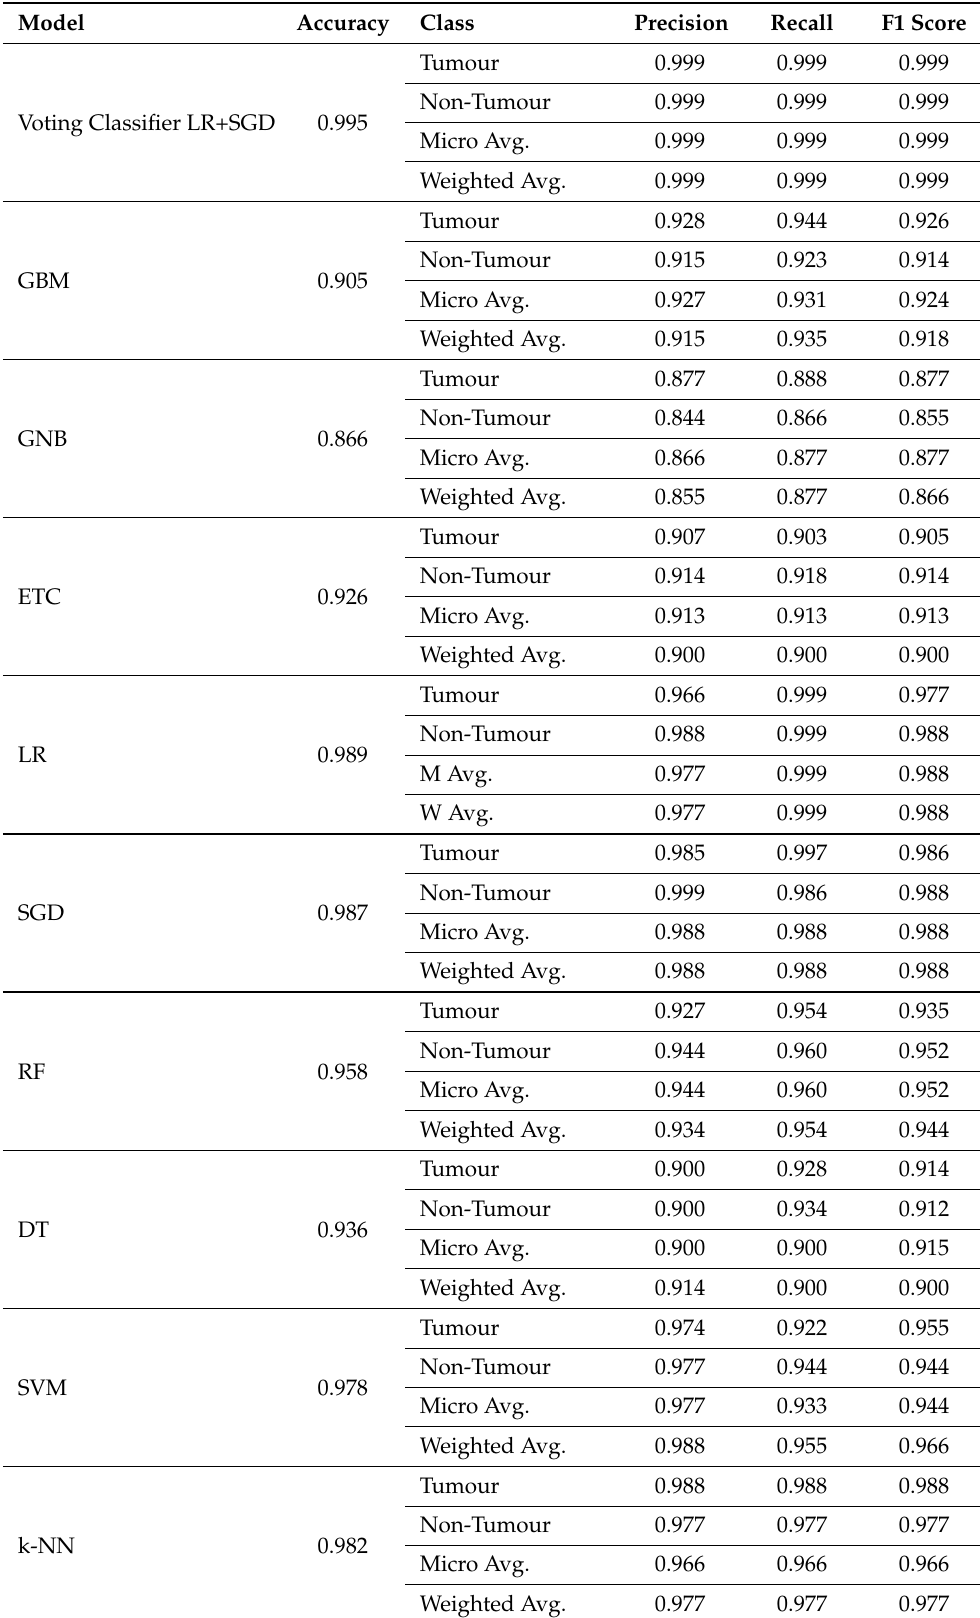
Table 3. Machine Learning Models Performance Using CNN as feature